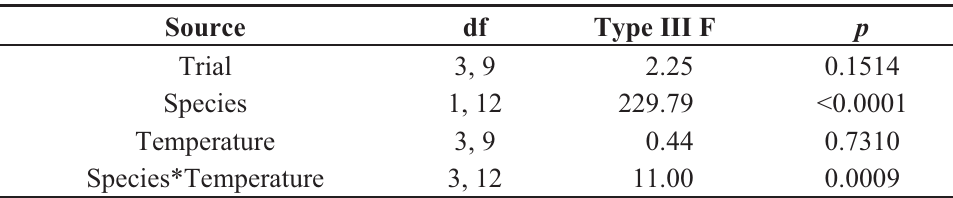
Figure 2. Mean total (±SE) tunneling distances (cm) per temperature for Nylanderia fulva (NF) and Solenopsis invicta (SI). Mean values within species not sharing the same letter are significantly different ( p < 0.05, LSD standardized test (SAS version 9.3, SAS Institute, Cary, NC, USA)). Table 1. A mixed model analysis evaluating the tunneling performance of Nylanderia fulva and Solenopsis invicta at 15.0, 18.0, 20.0, and 22.0